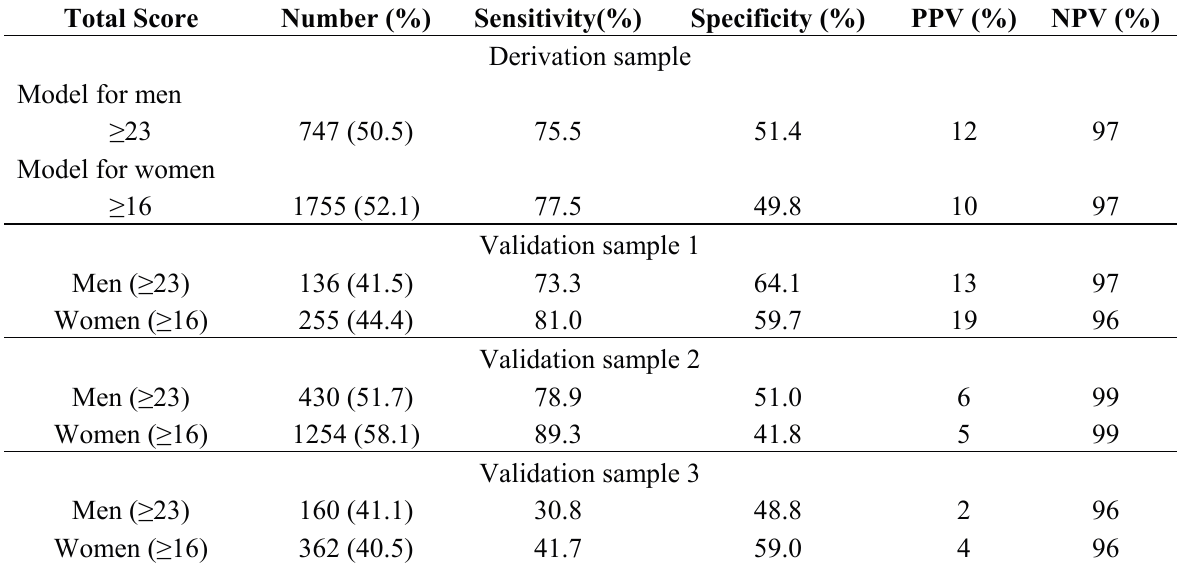
Table 4. The performance of the risk score at cut-off points for detecting IFG in the derivation sample and validation